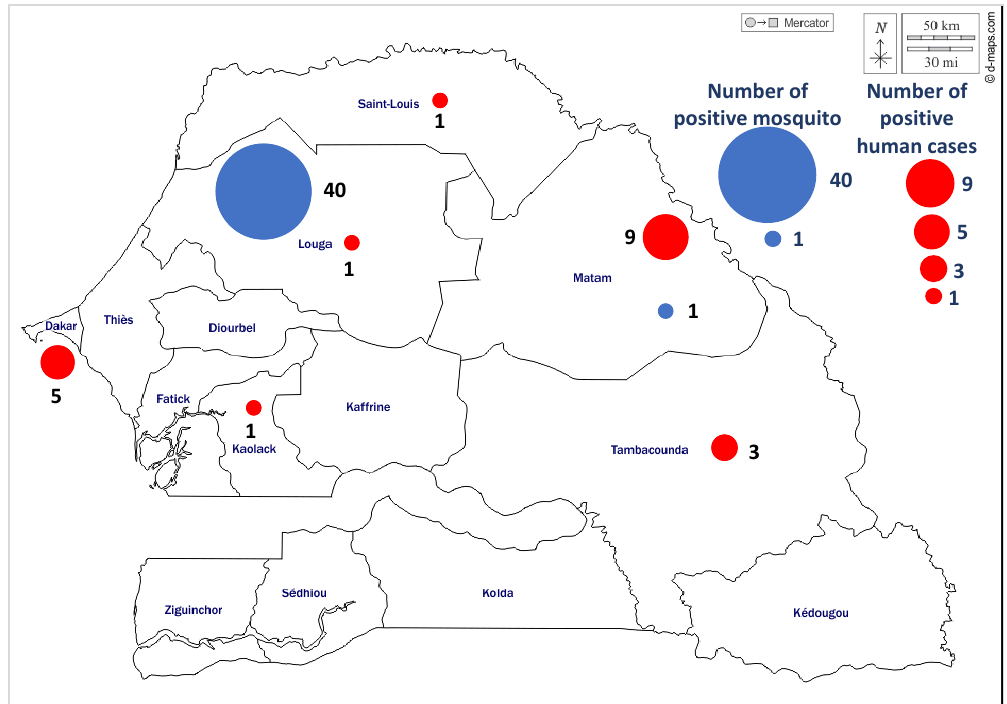
Figure 2. Geographical distribution of human and mosquito cases of WNV in Senegal from 2016 to 2021. Red dots show regions where WNV positive human cases were isolated and blue dots where WNV positive mosquitoes were isolated. Human cases are found according to this map mainly in the north, the west and the south east of Senegal, and mosquito cases mainly in the north.